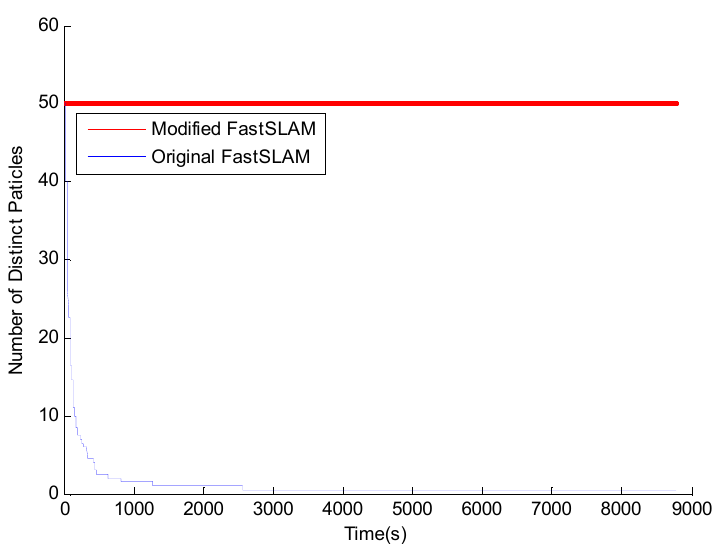
Figure 6. Number of distinct particles over time. The particle number used is